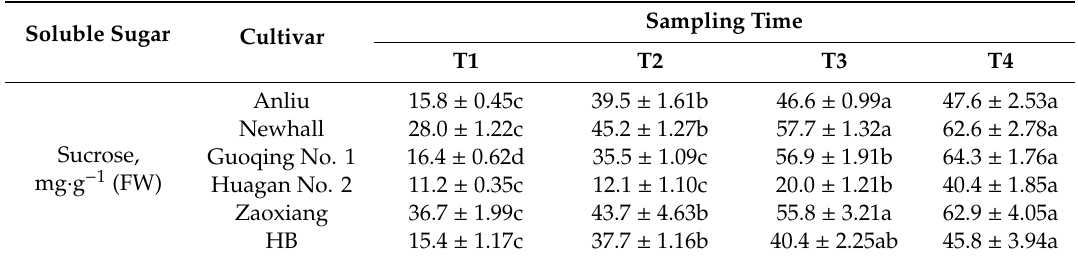
Table 1. Soluble sugar concentrations in fruit juice sacs during fruit development of six citrus cultivars. Soluble Sugar